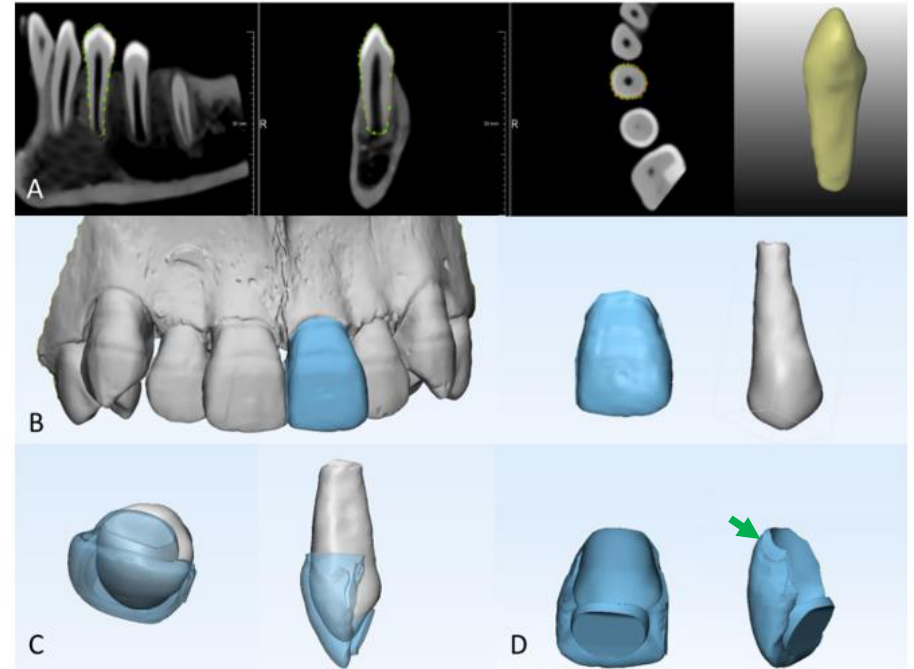
Figure 1. Digital flow for temporary veneer preparation. ( A ) Premolar segmentation; ( B ) designing temporary veneer based on the shape of the contralateral incisor (to mimic the clinical situation where one maxillary central incisor will be lost, a mirror image of the contralateral maxillary incisor was used to design the temporary veneer that will fit the transplanted premolar); ( C ) checking veneer thickness to ensure optimal printing; ( D ) final veneer design: removing undercuts, beveling the edges (green arrow), and inspecting the surface thickness is done to avoid print failure spots.